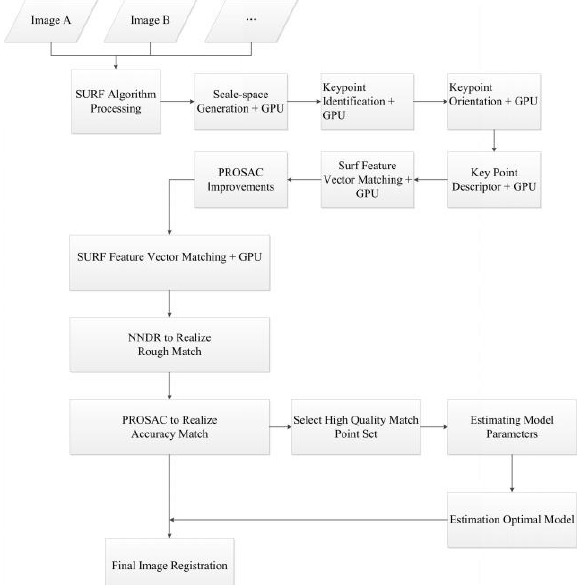
Figure 4. The improved SURFGPU algorithm